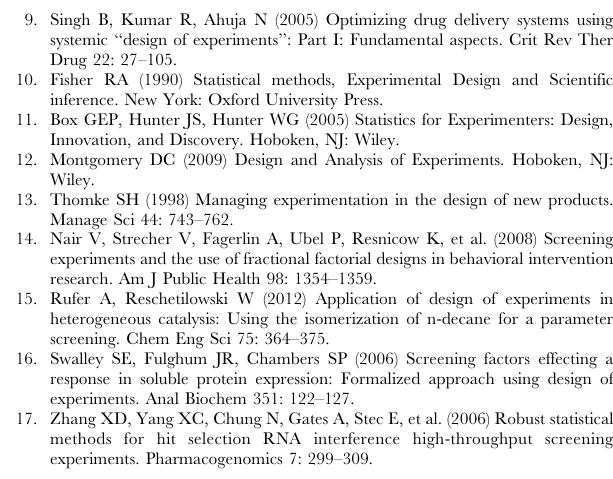
Table S1 Filtration experiment inputs [ 11 ] .